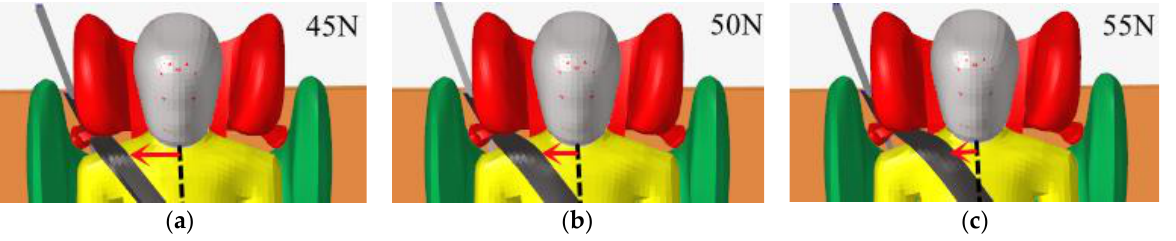
Figure 11. Different initial contact positions between the shoulder belt and the shoulder: the shoulder belt leaning outward relative to the reference model with an initial tension of 45N; ( a ) the reference model with an initial tension of 50N; ( b ) the shoulder belt leaning inward relative to the reference model with an initial tension of 55N ( c ).